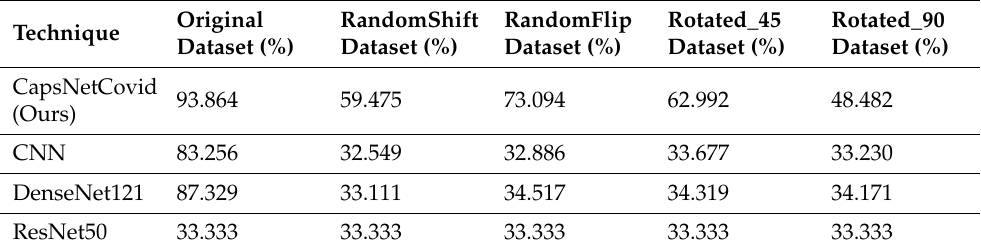
Table 12. Precision for CapsNetCovid, CNN, DenseNet121, and ResNet50 for multi-class classification.